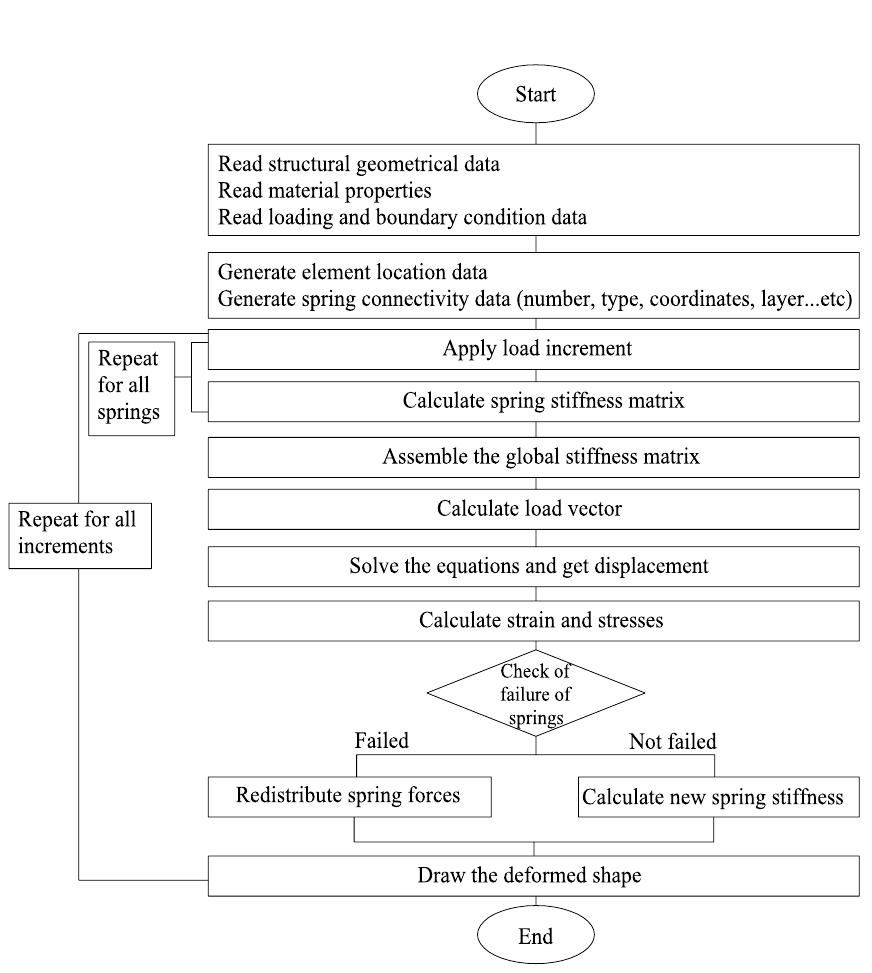
Fig. 3 Flow chart of the IAEM (El‑Kholy et al.,